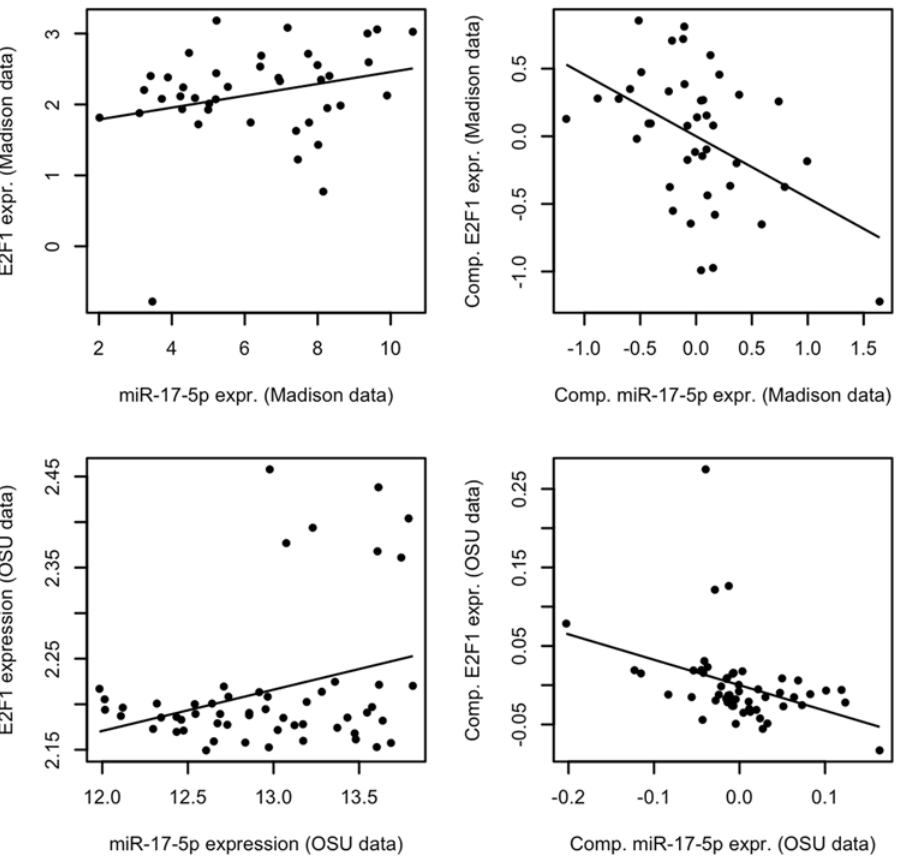
Figure 3. Marginal and system biology-compensated E2F1 and miR-17-5p expression levels. E2F1 and miR-17-5p expression levels in the Madison data are compared marginally in the top left and after compensation for biological and idiosyncratic covariates on the top right. Analogous results for the OSU data are provided in the bottom row. In either dataset, marginal RNA expression levels are not representative of the known targeting relationship between miR-17-5p and E2F1. After compensation the relationship between these RNAs can be observed.